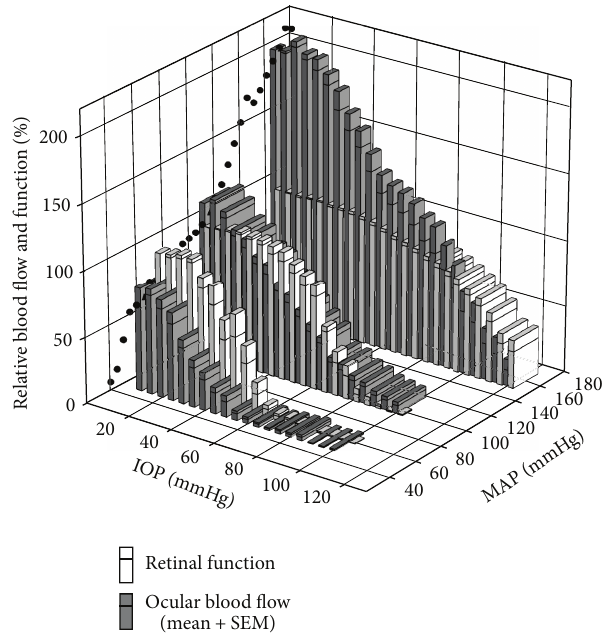
F 9: Comparison of relative retinal function and ocular blood �ow during IOP elevation in animals with acute low, moderate, and high blood pressure. Black circles: blood �ow autoregulation curve at baseline IOP. Function (un�lled bars, b-wave amplitude) is normali�ed to baseline. Starting blood �ow (�lled bars) is ad�usted based on the autoregulation curve. Bars represent mean + SEM. Reprinted from [89] with